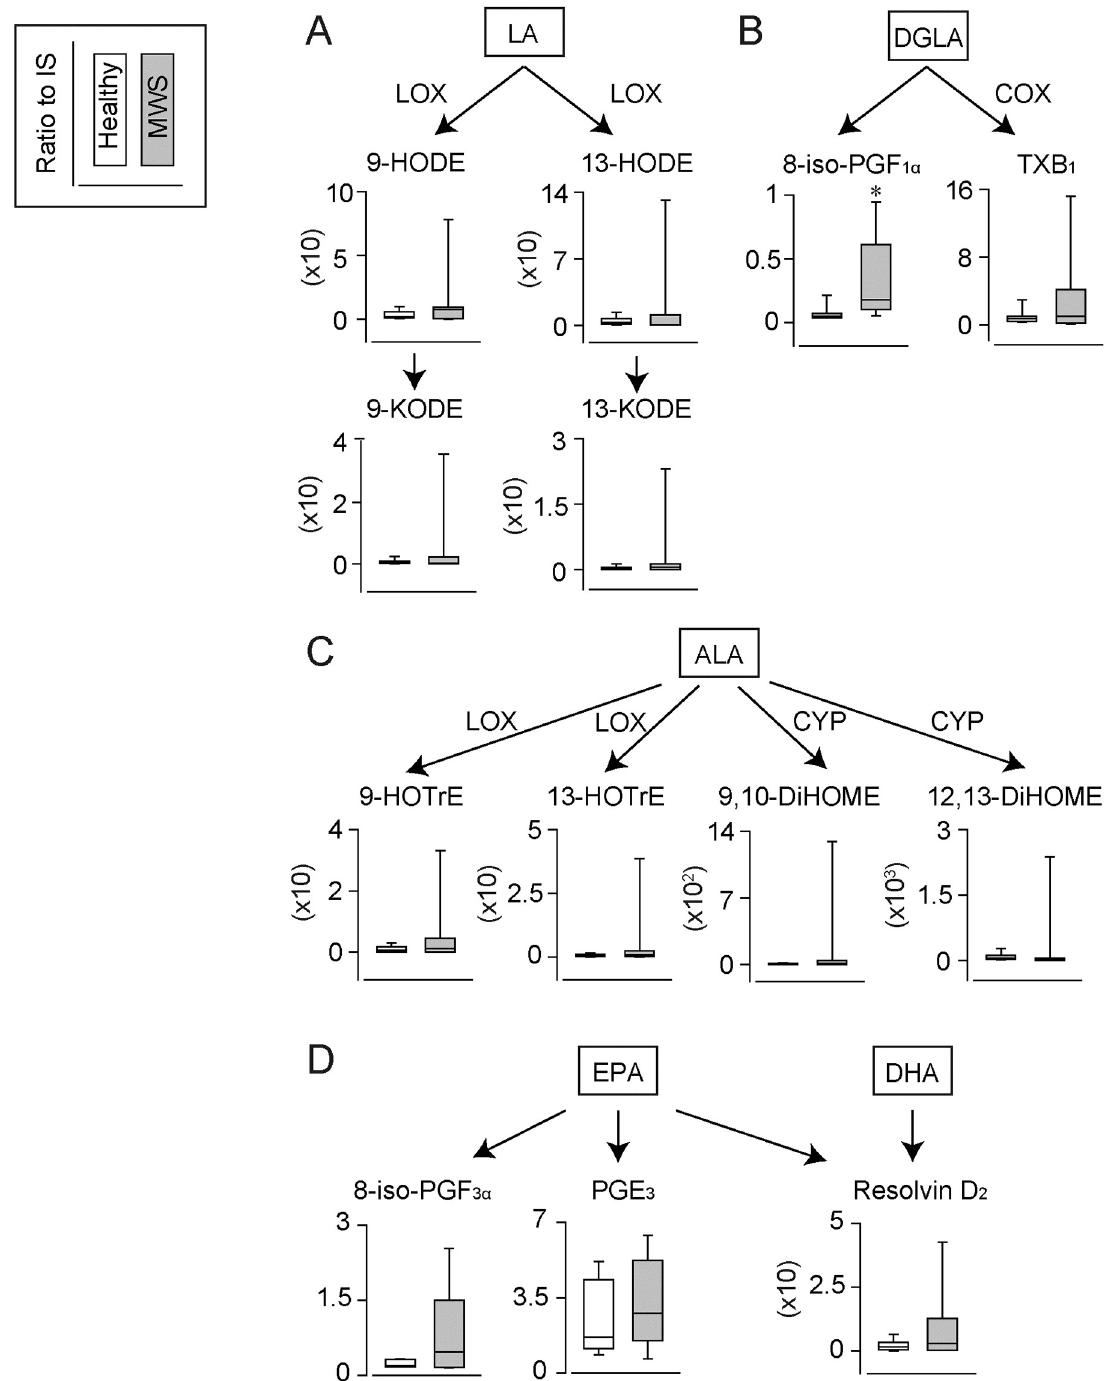
Fig 4. The urinary levels of lipid metabolites derived from PUFAs except AA. The urinary levels of (A) linoleic acid (LA), (B) dihomo- γ -linolenic acid (DGLA), (C) α -linoleic acid (ALA), (D) eicosapentaenoic acid (EPA) and (E) docosahexaenoic acid (DHA)-derived metabolite in healthy marmoset (N = 7) and marmosets with MWS (N = 7). � p < 0.05 compared to healthy urines. LOX, lipoxygenase; COX, cyclooxygenase; CYP, cytochrome P450 epoxygenase.